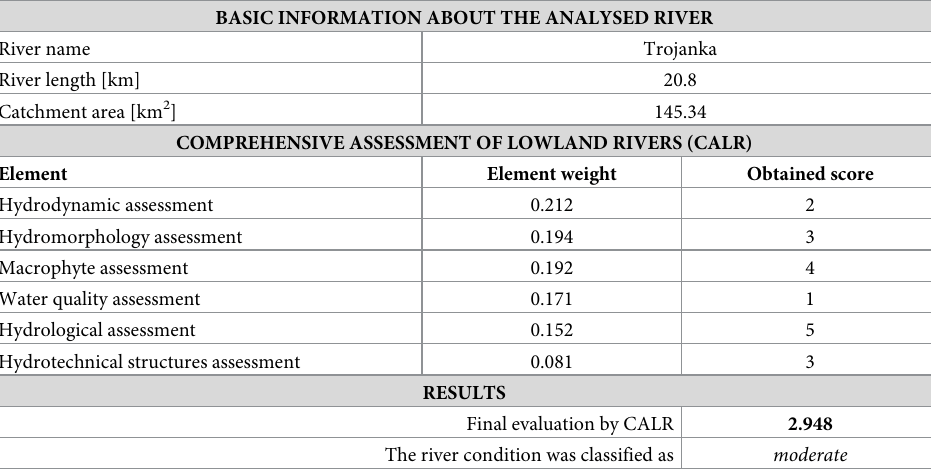
Table 6. Assessment form for carrying out the Comprehensive Assessment of Lowland Rivers (CALR).